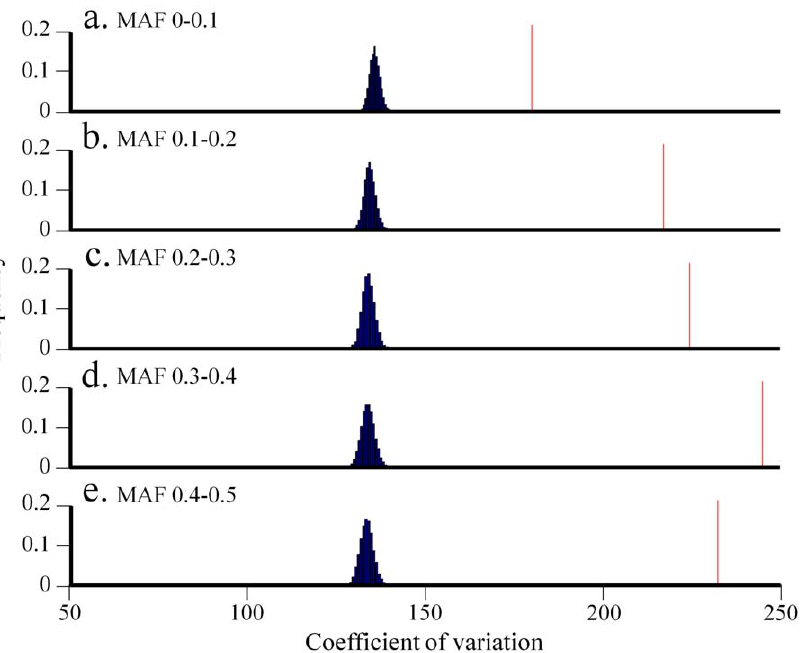
Figure 7. Comparing the coefficient of variation for high- and low- F ST SNPs. Frequency distribution of coefficient of variation calculated between adjacent F ST . threshold SNPs (line) and between random samples of F ST , threshold SNPs (histogram) for five allele frequency groups (a–e).